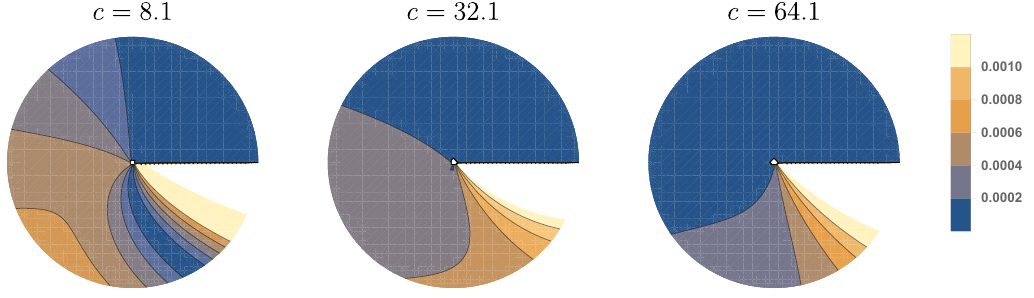
(cid:12) (cid:12) V exact 0 (cid:0)V semi 0 (cid:12) (cid:12) (cid:12) (cid:12) V semi 0